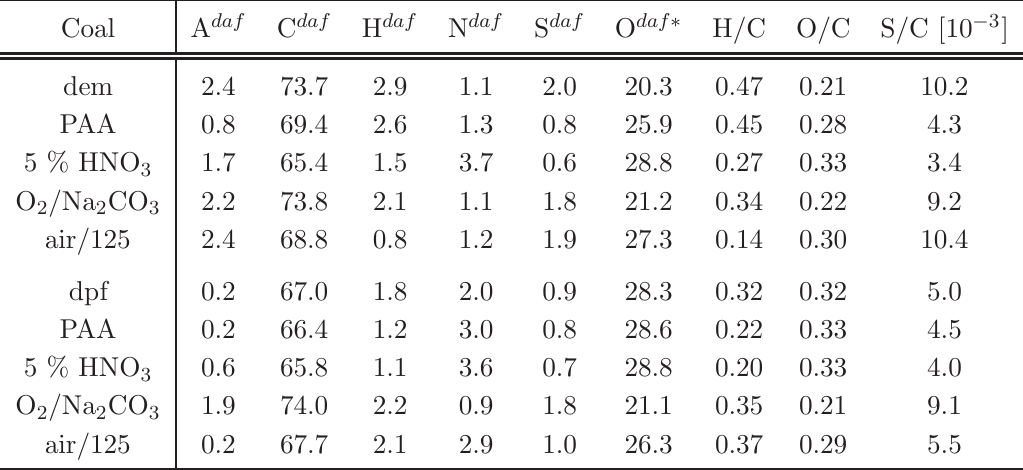
Table 3 Results of the elemental analysis of the solid products of extraction with THF [wt %] and molar ratios of H/C, O/C and